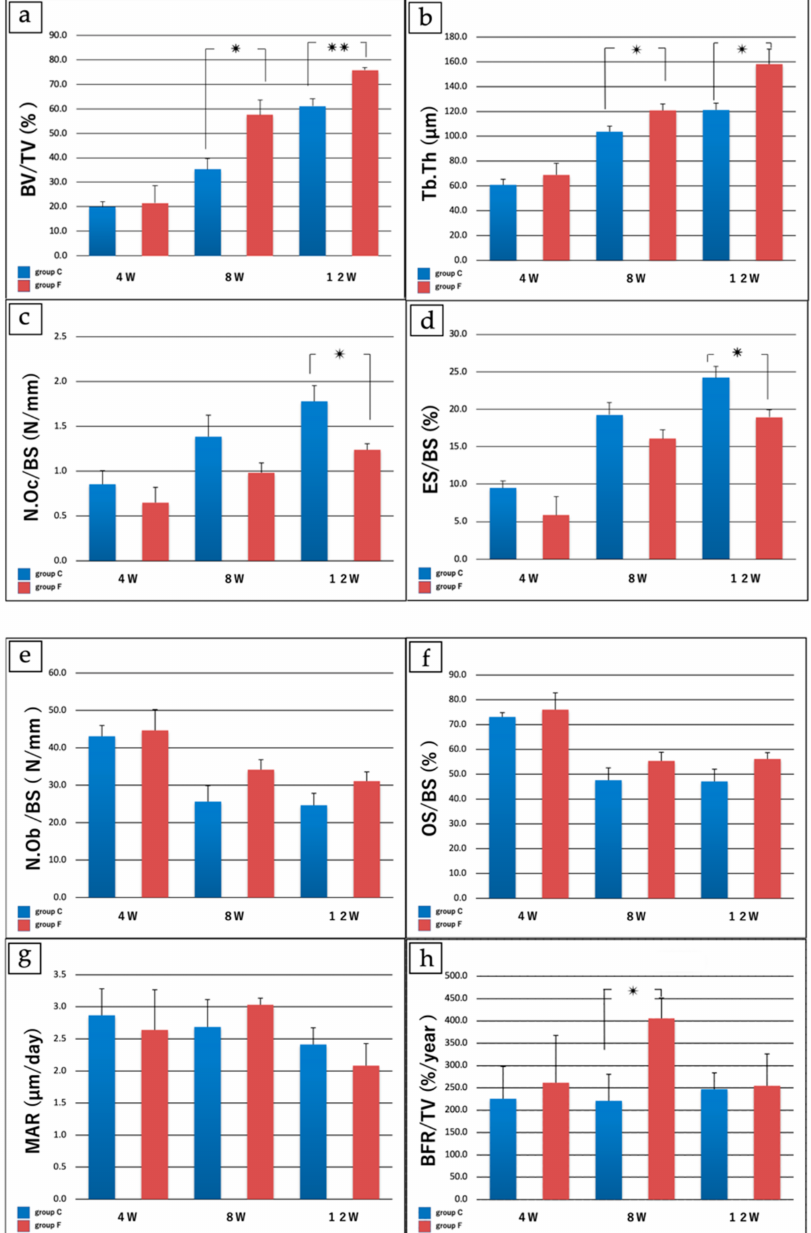
Figure 8. Results of bone histomorphometry. ( a ) Bone volume/tissue volume (%). At Week 4 no significant differences were noted between groups. At Week 8 bone volume/tissue volume (%) was 35.37 ± 8.70 in Group C vs. 57.53 ± 12.4 in Group F ( p < 0.05), and at Week 12 was 61.17 ± 2.12 in Group C vs. 75.77 ± 5.88 in Group F ( p < 0.005), with a significantly greater increase in Group